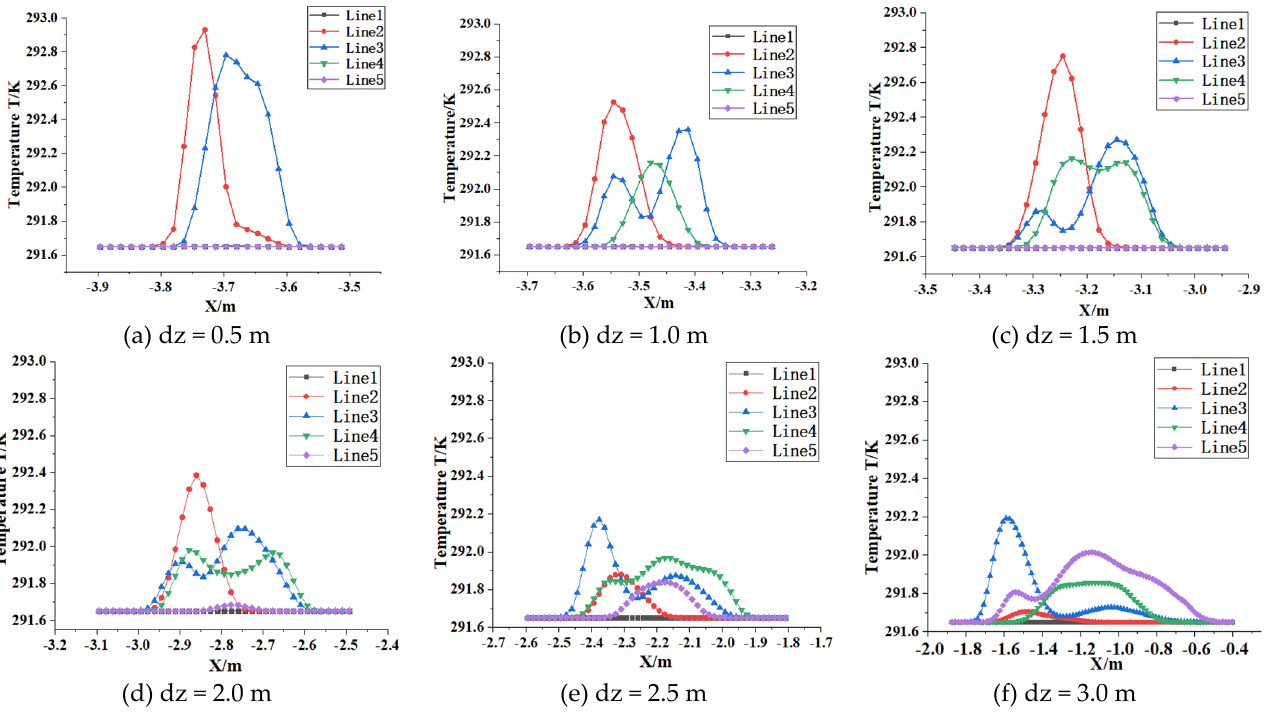
Figure 17. Line temperature distribution at different sections behind the underwater vehicle.